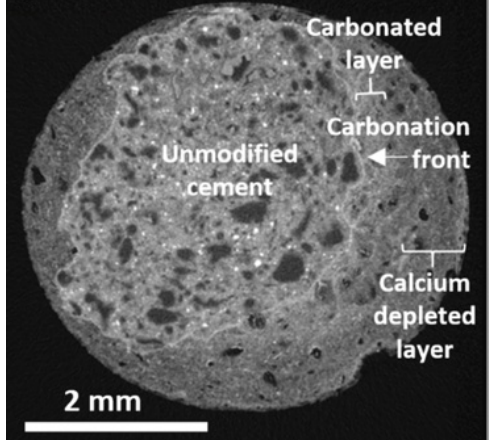
Figure 3. SEM observation of carbonated specimen with the red line showing the edge of non-car- bonated and carbonated areas [60].